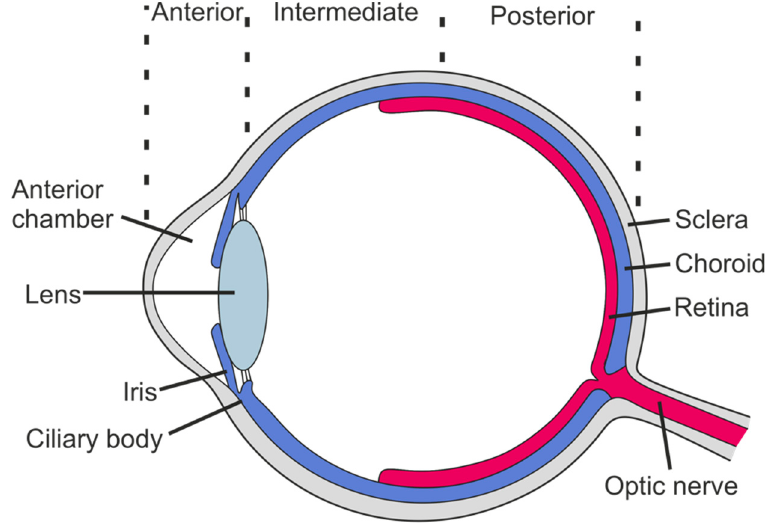
Figure 1. Anatomy of the eye. Cross-section of the human eye with major anatomical features highlighted.